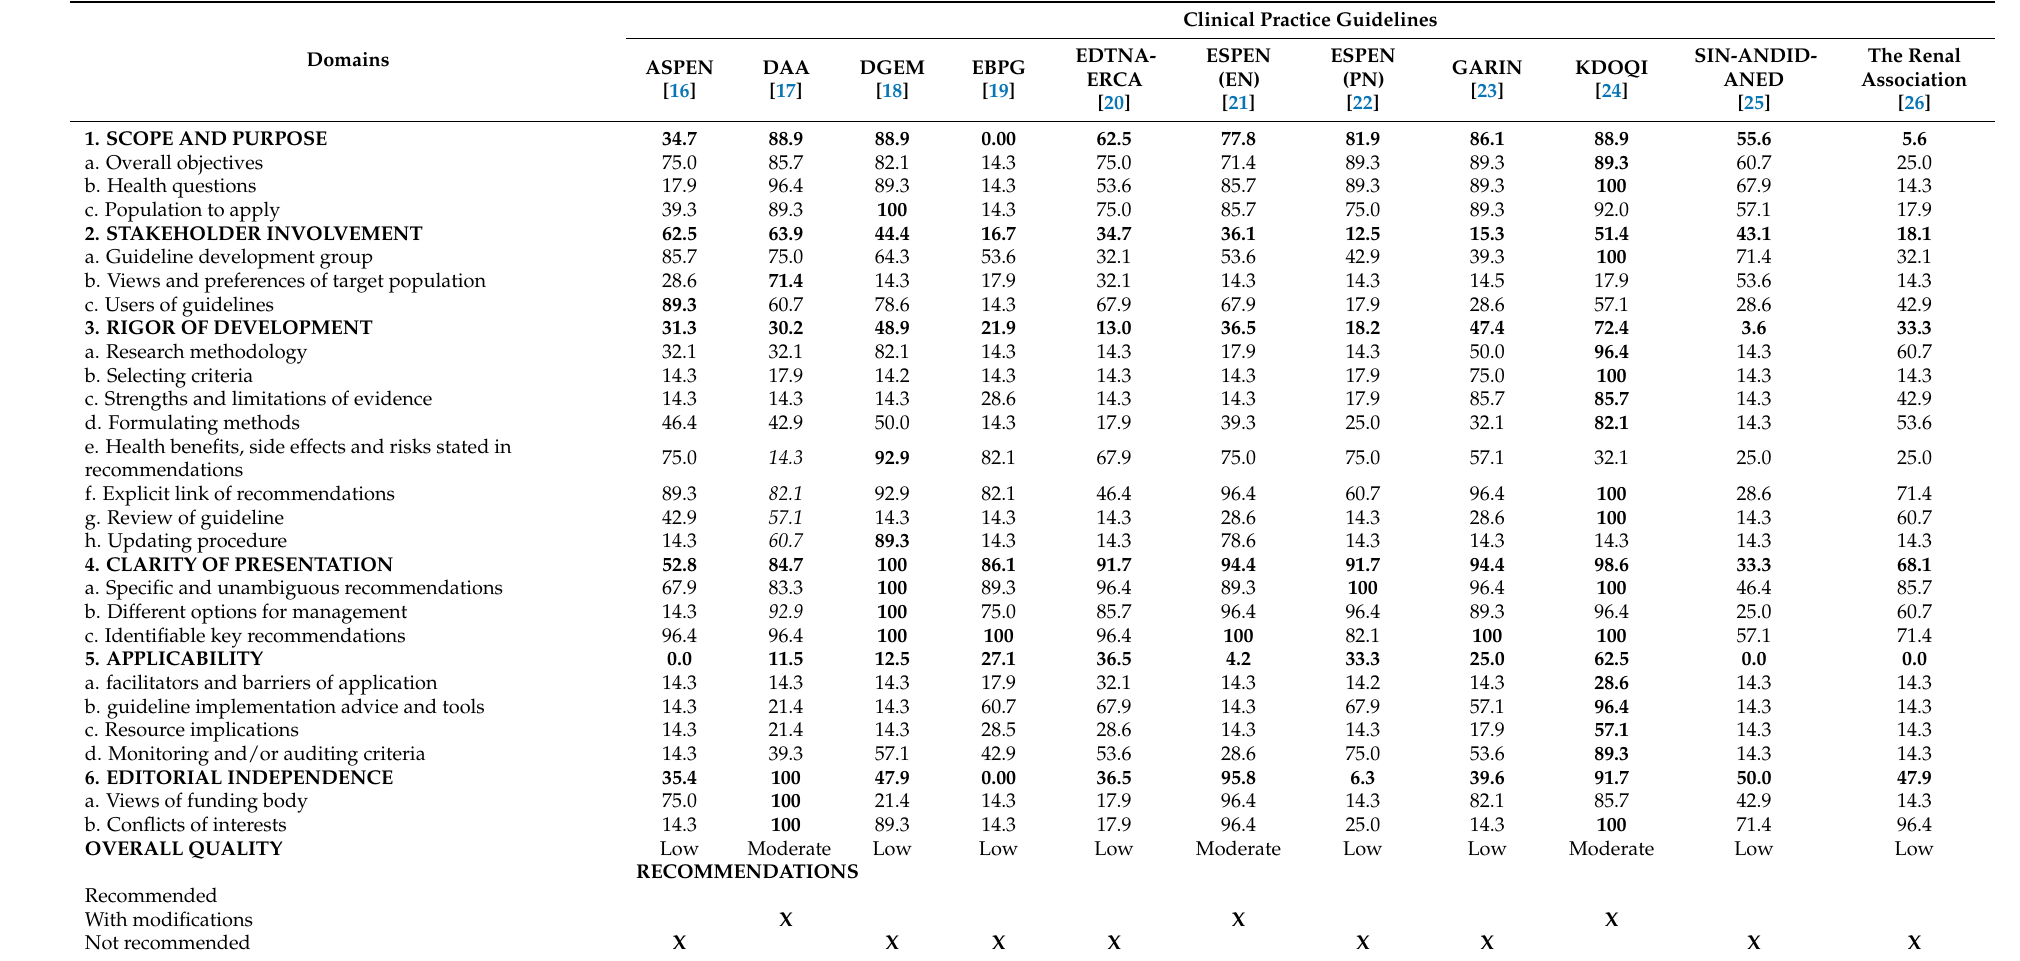
Table 2. Appraisal of Guidelines for Research and Evaluation (AGREE) II results for clinical practice